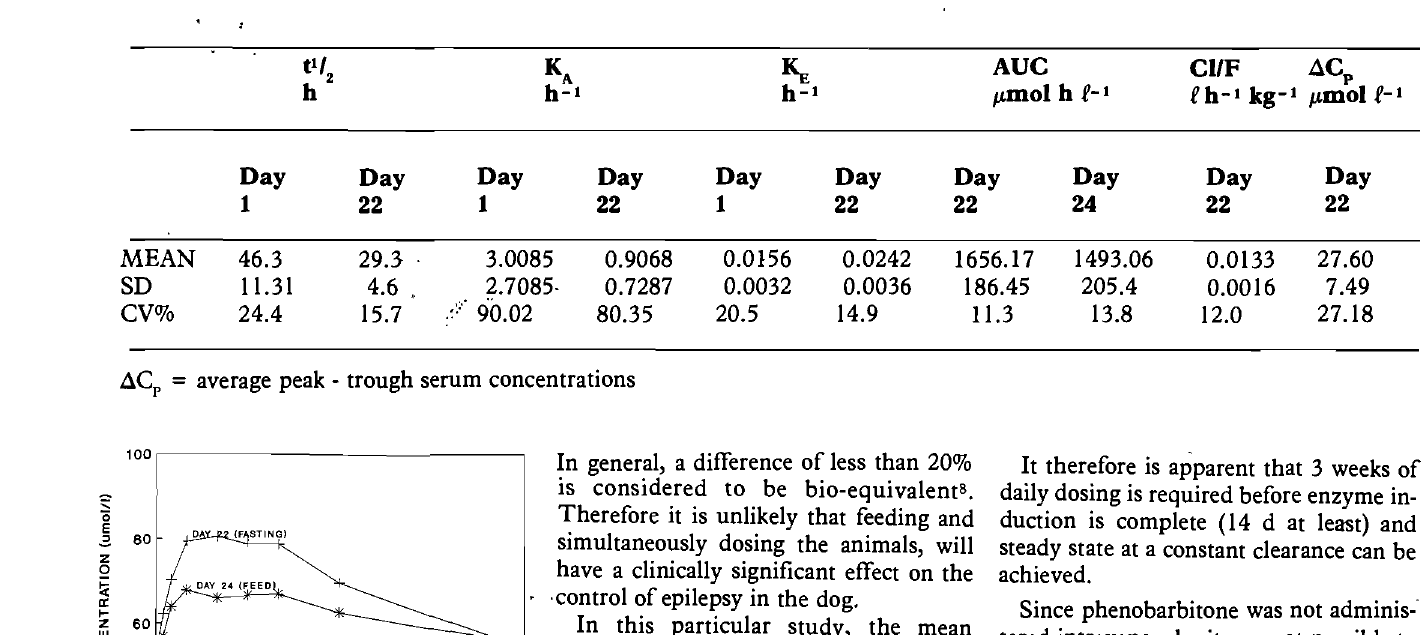
Table 2: Phenobarbitone pharmacokinetics in dogs given phenobarbitone once daily per os